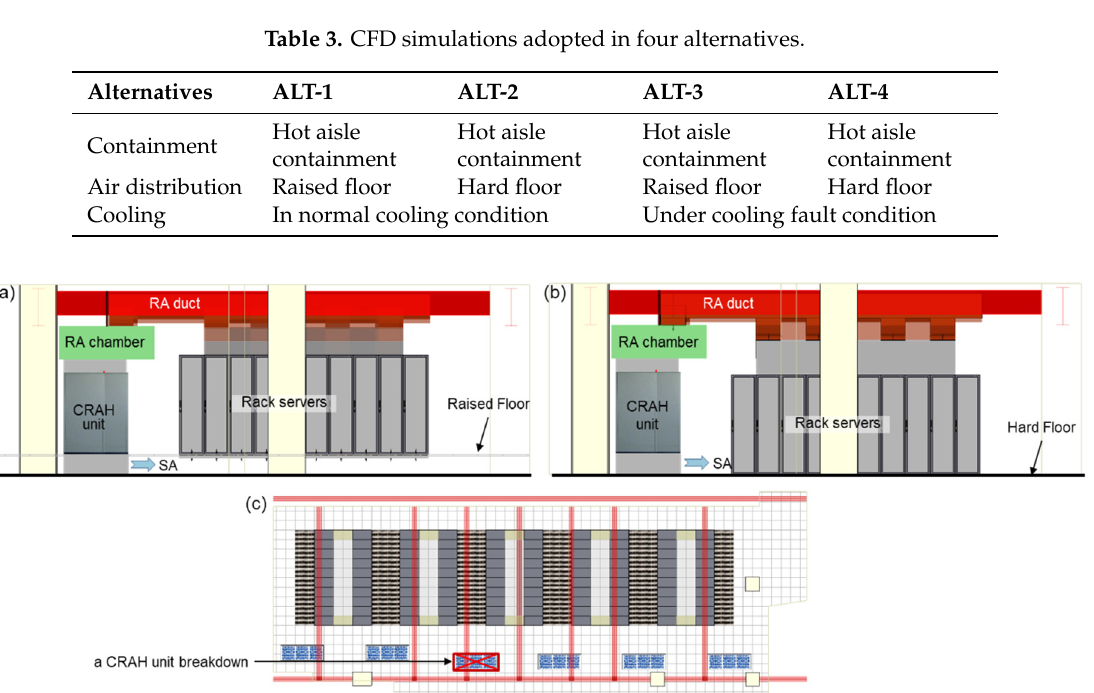
Figure 5. CFD analysis alternatives; ( a ) HAC with raised floor (ALT-1, ALT-3), ( b ) HAC with hard floor (ALT-2, ALT-4) and ( c ) Under cooling fault condition (ALT-3, ALT-4).